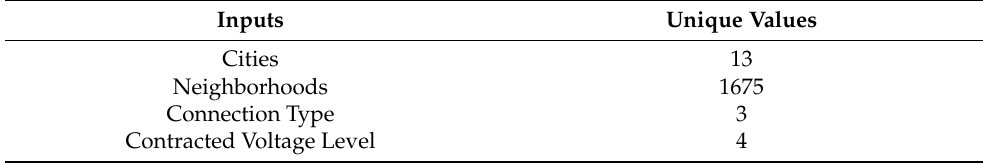
Table 7. Inspected Consumer Units Labeled Regular.